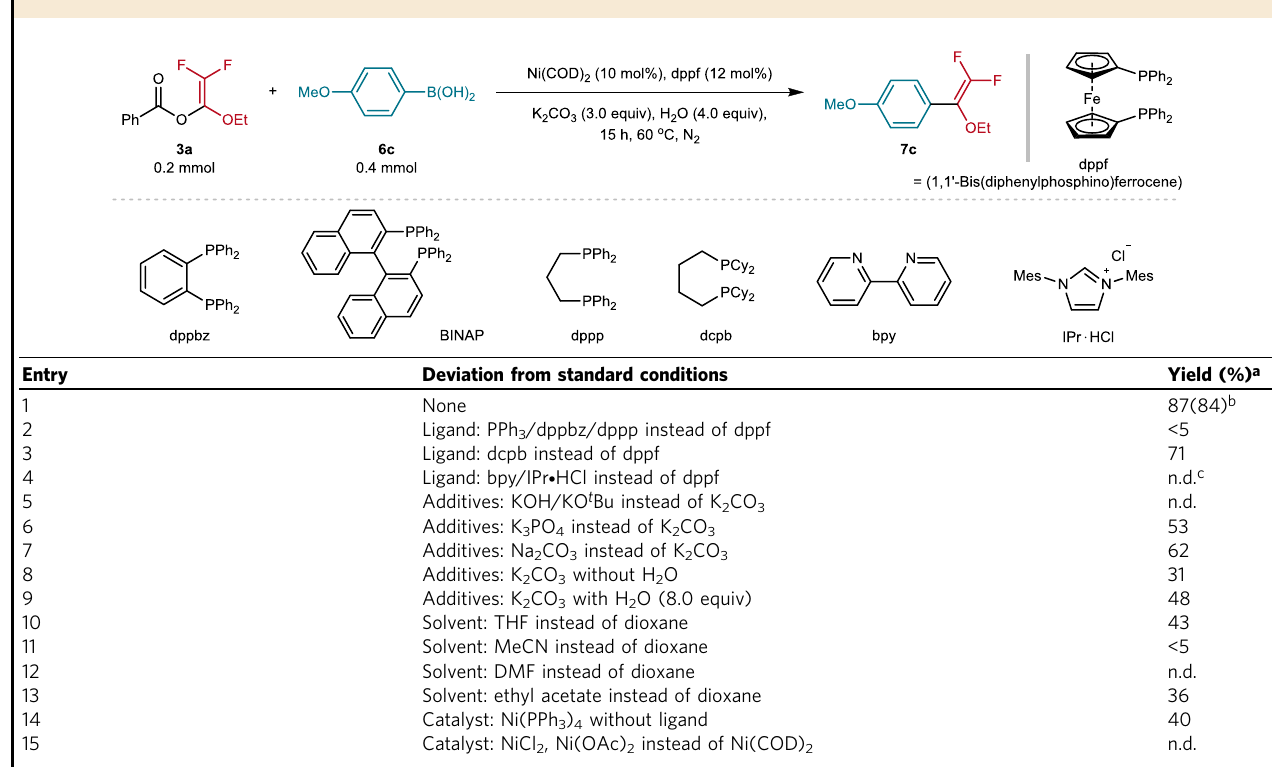
Table 1 Optimization of reaction